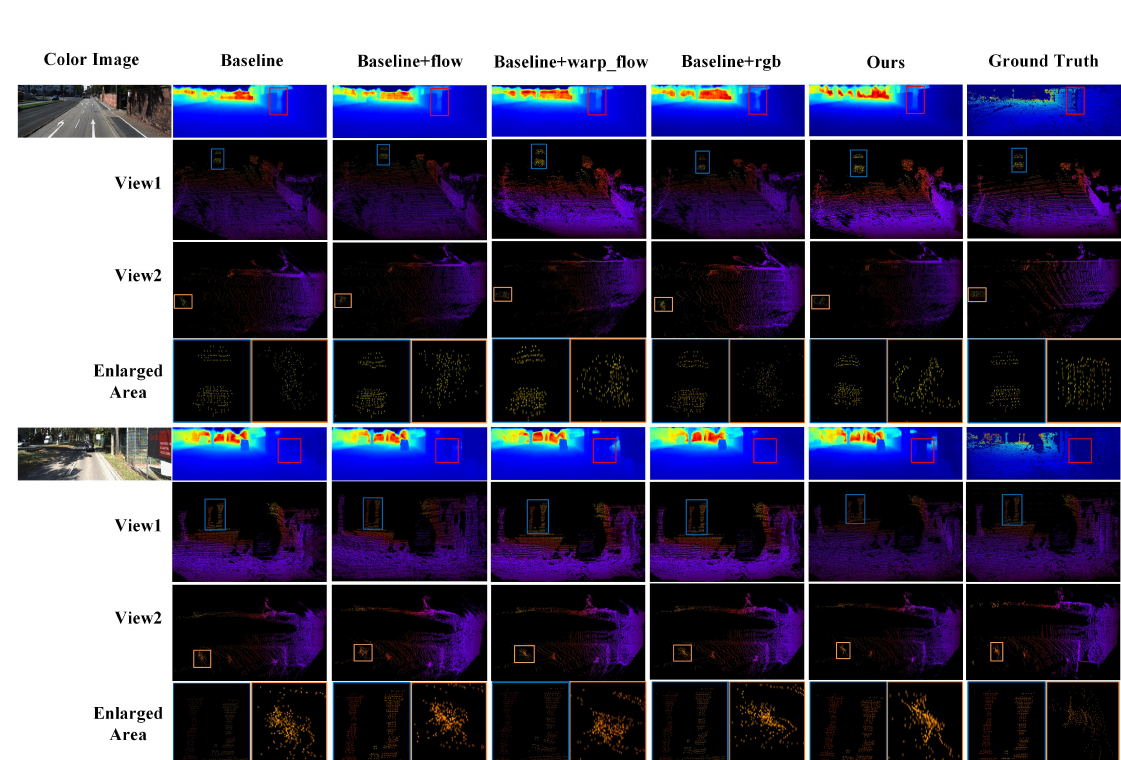
Figure 4. Visual results of the ablation study. We show the color image, interpolated dense depth map, two views of the generated Pseudo-LiDAR, and enlarged areas. The complete network produces more accurate depth map, and the distribution and shape of Pseudo-LiDAR are more similar to those of the ground truth point